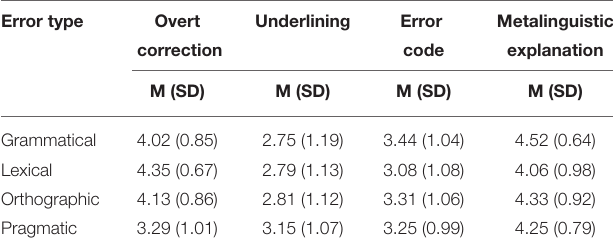
TABLE 5 | Descriptive statistics of rating scores for the WCF types on specific errors. Error